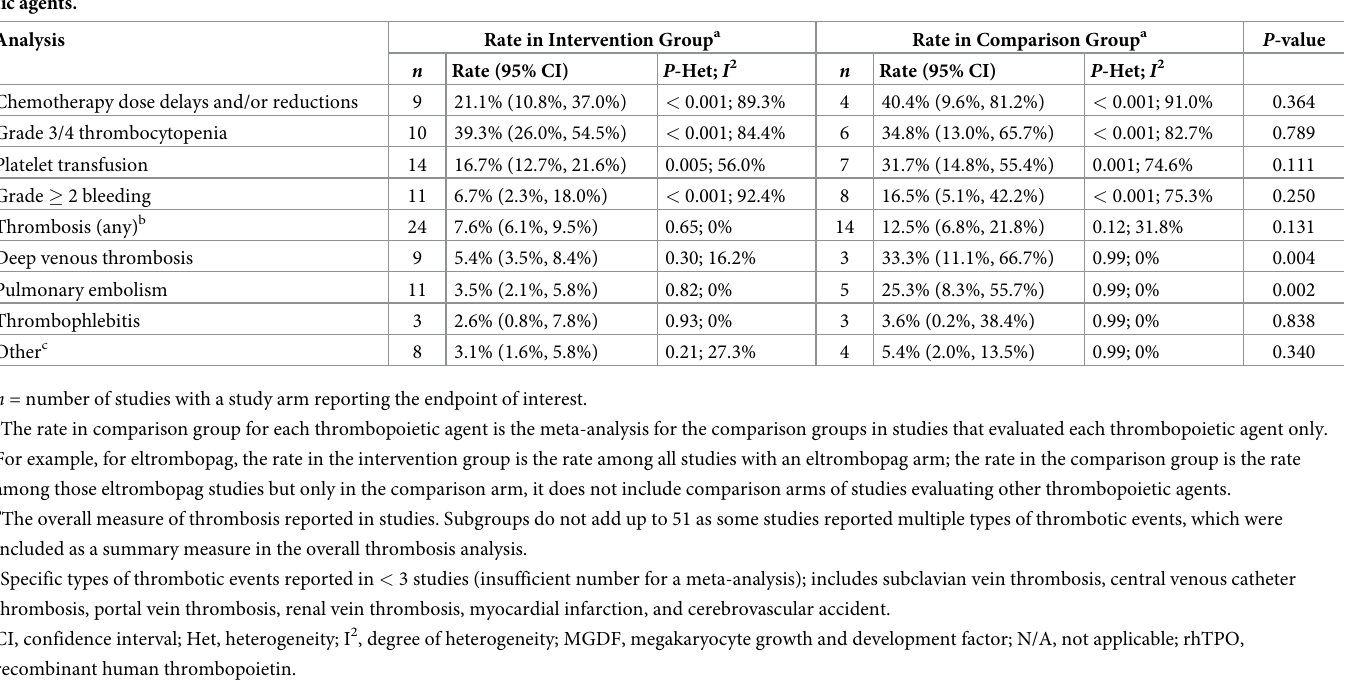
Table 2. Meta-analysis results for efficacy and safety outcomes for thrombopoietic agent versus placebo or no treatment by combined and individual thrombopoie- tic